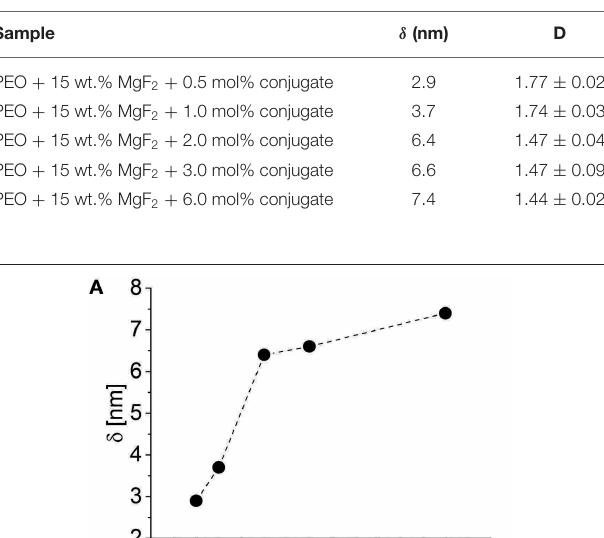
TABLE 1 | Results for conjugate layer thickness δ and fractal dimension D.